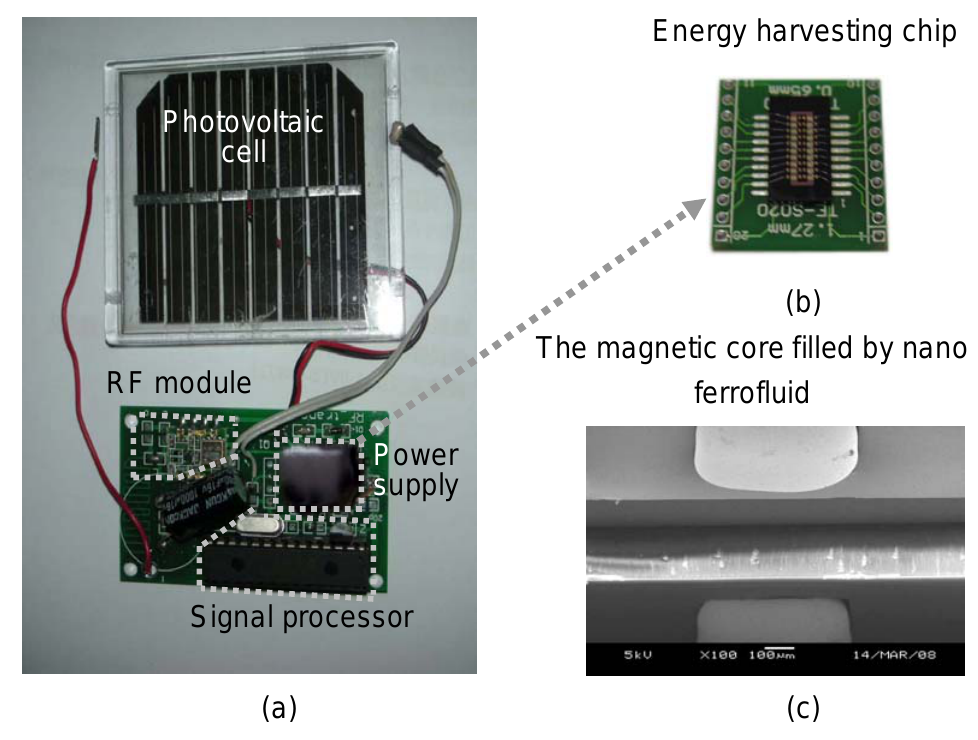
Figure 3 . The pictures of sensor node with the energy harvesting power supply module (a), the energy harvesting chip core (b), and the SEM picture of the magnetic core (c) of the chip made by post MEMS